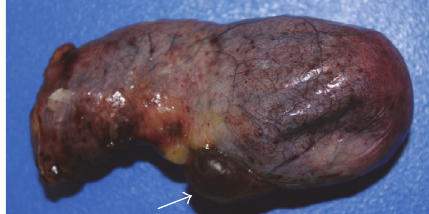
Figure 1: Gross image of resected specimen with ectopic liver tissue present on gallbladder (arrow).